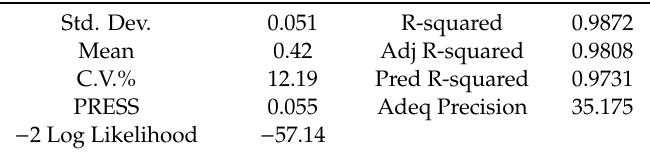
Table 5. Predicted R-square vs. adjusted R-square.